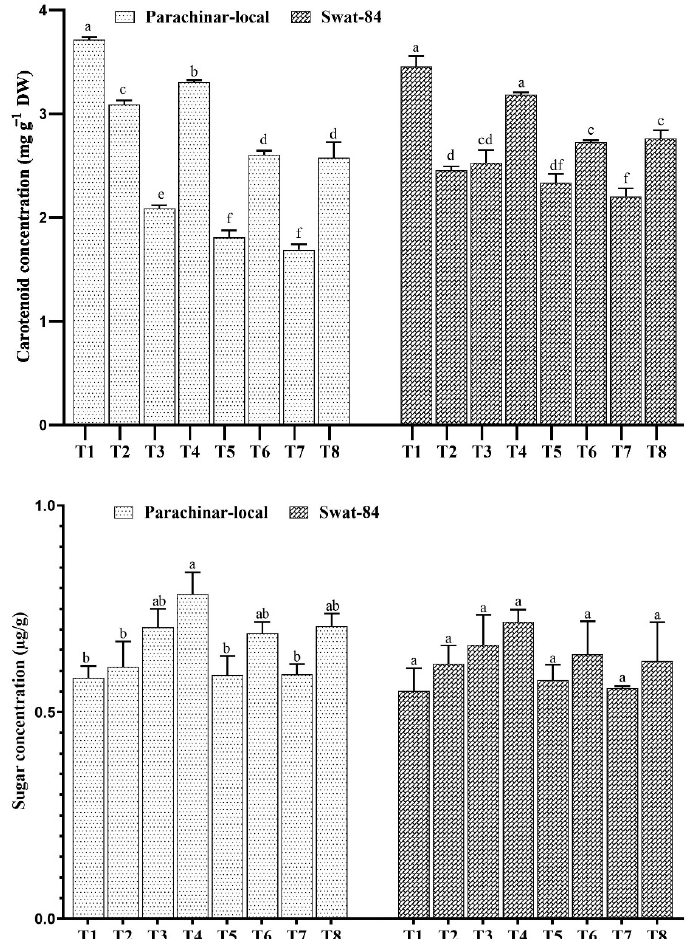
Figure 2. Changes in carotenoids and sugar concentration under salt stress and exogenous JA application. Different letters for each column for each variety show significantly different values at p < 0.05 according to Duncan’s method. T1 (Control), T2 (Control + JA), T3 (40 mM), T4 (40 mM + JA), T5 (80 mM), T6 (80 mM + JA), T7 (120 mM), T8 (120 mM + JA).